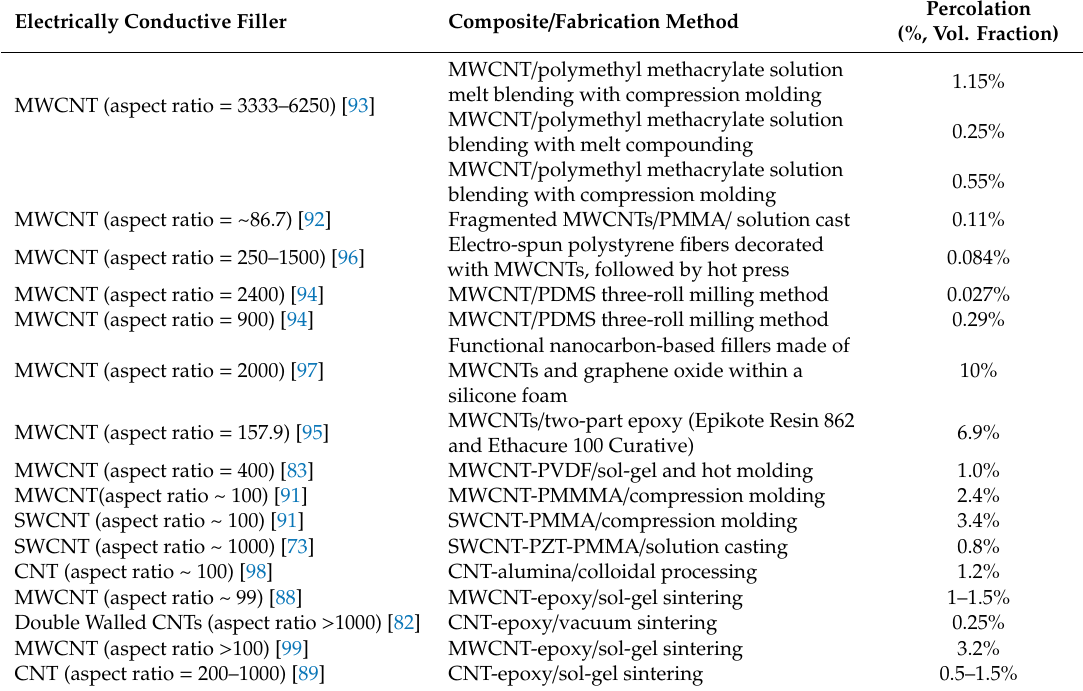
Table 1. Variation of percolation threshold with the variation in aspect ratio of the electrically conductive inclusion